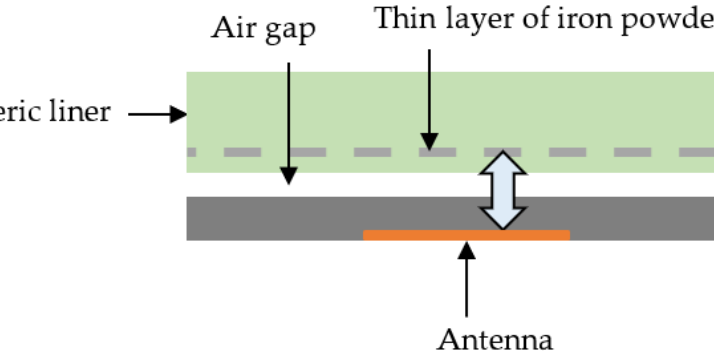
Figure A1. Sensor in a socket. The antenna is on the bottom side of the insert. The system measures the distance between the antenna and the iron powder within the liner (light blue double arrow). The system is calibrated to record the distance between the inside of the insert and the outside of the liner. Example data from approximately 0.5 min during take-home testing are shown in Figure A2. Data are from the posterior sensor.